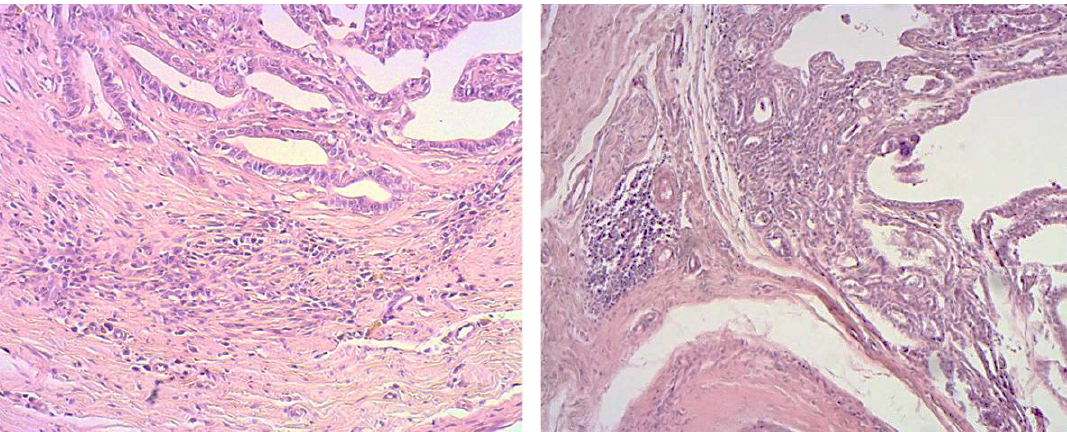
Figure 1. Inflammatory infiltrate in the stromal areas of tubulopapillary carcinoma (grade I) with the appearance of bands and aggregates.